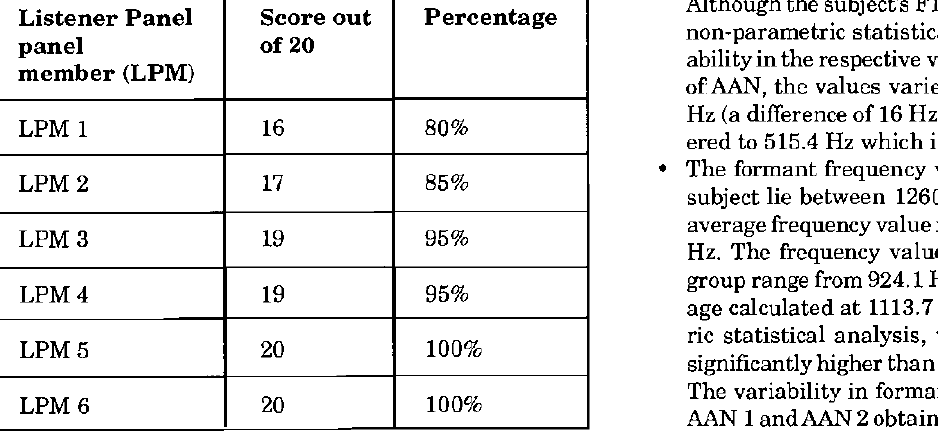
TABLE 6: Scores obtained by the semi-sophisticated listener panel in the intelligibility rating